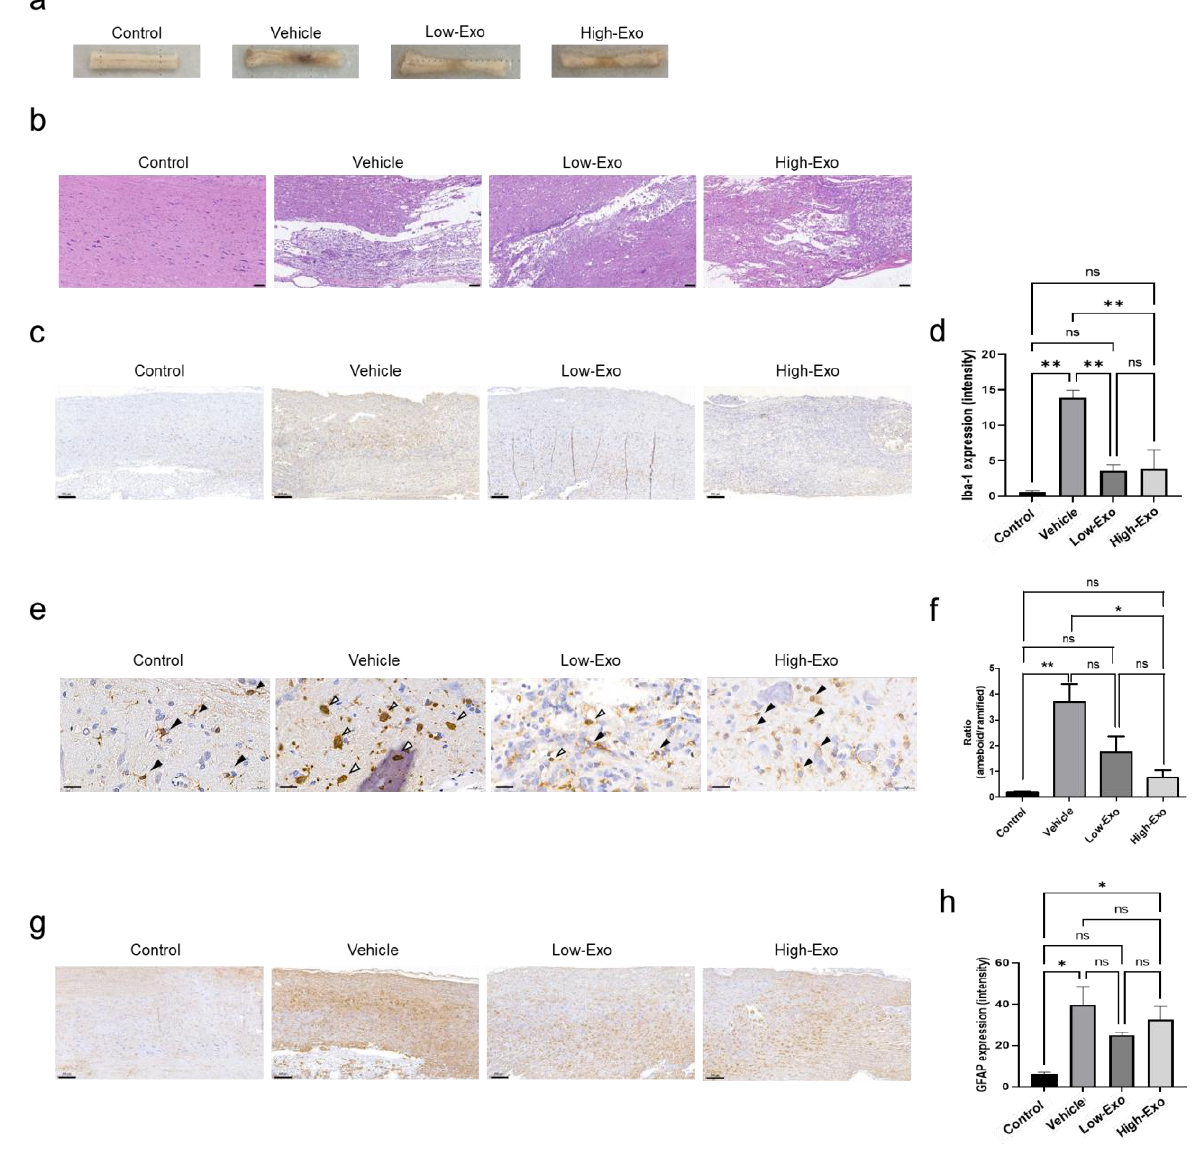
Figure 4. Histopathology and immunohistochemistry analysis of Iba-1 and glial fibrillary acidic pro- tein (GFAP) in the rat spinal cord: ( a ) representative images of spinal cord gross findings after sacrifice. The spinal cord tissues were damaged by compression stimulation; ( b ) the spinal cord tissues were sec- tioned longitudinally and stained with hematoxylin and eosin. (Scale bar = 100 µ m); ( c ) immunode- tection of Iba-1 in the non-treated and SCI-induced rats (scale bar = 200 µ m); ( d ) quantification of Iba-1 expression by DAB staining; ( e ) representative images of Iba-1 microglia states (scale bar = 20 µ m, black arrow: ramified, white arrow: ameboid); ( f ) quantification of Iba-1 morphology ratio (ameboid and ramified microglia); ( g ) immunodetection of GFAP in the non-treated and spinal cord injured rats. (Scale bar = 200 µ m); ( h ) quantification of GFAP expressing intensity by DAB staining. (* p ≤ 0.05, ** p ≤ 0.001, ns = not